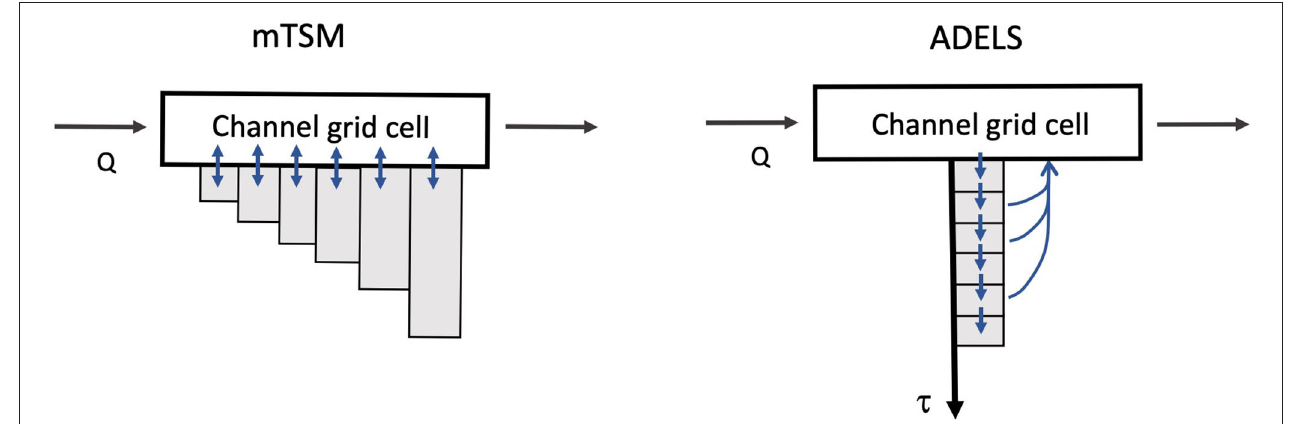
FIGURE 1 | Schematic showing mesh topology for two approaches for representing the effects of hyporheic exchange in models of reactive transport in stream and river corridors. The multirate Transient Storage Model (mTSM) considers multiple transient storage zones of different sizes that are each coupled to the channel by first-order reversible mass exchange. The ADELS model represent an ensemble of streamlines that are diverted into the hyporheic zone before returning to the stream channel using a one-dimensional advection-reaction equation written in Lagrangian form with hyporheic age τ replacing the spatial coordinate. The two conceptualizations are equivalent for non-reacting tracer transport, but not for reactive